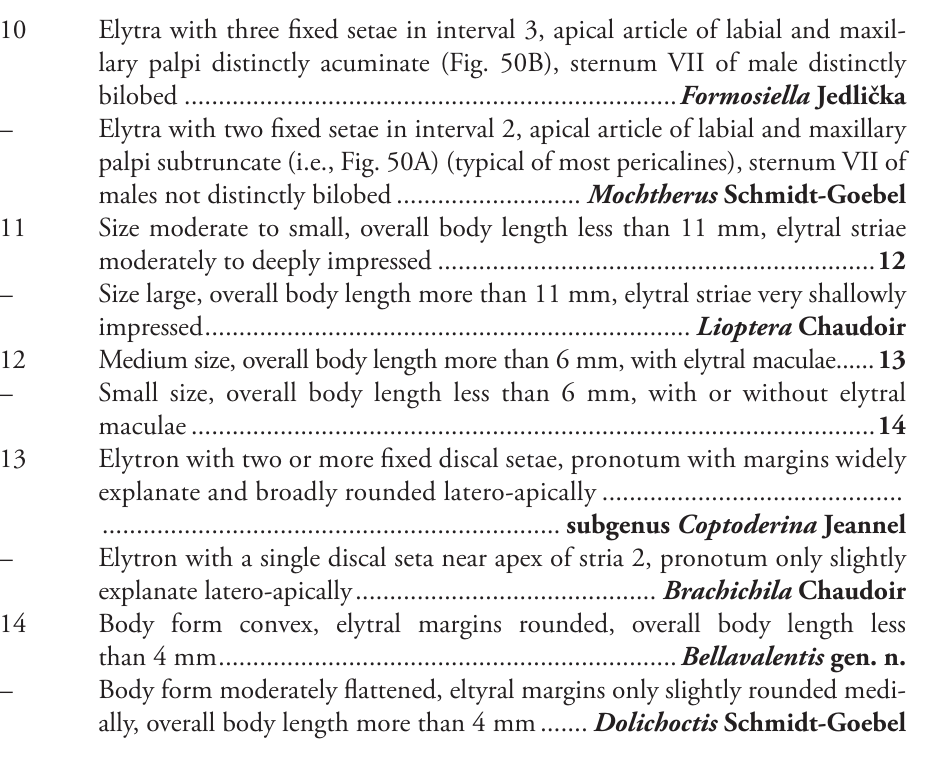
Pilosity . Dorsum of head and pronotum glabrous. Fixed setae. Two pairs of supraorbital setae; clypeus with two lateral setae; labrum with six setae along apical margin; one pair of suborbital setae; pronotum with two setae along each margin; elytra with one seta in basal third of stria 3, two setae in api- cal third of stria 2; 16–17 lateral (umbilical) setae in interval 9; two setae on each of abdominal sterna III to VI, two setae along apical margin of sternum VII in males, four setae along apical margin of sternum VII in